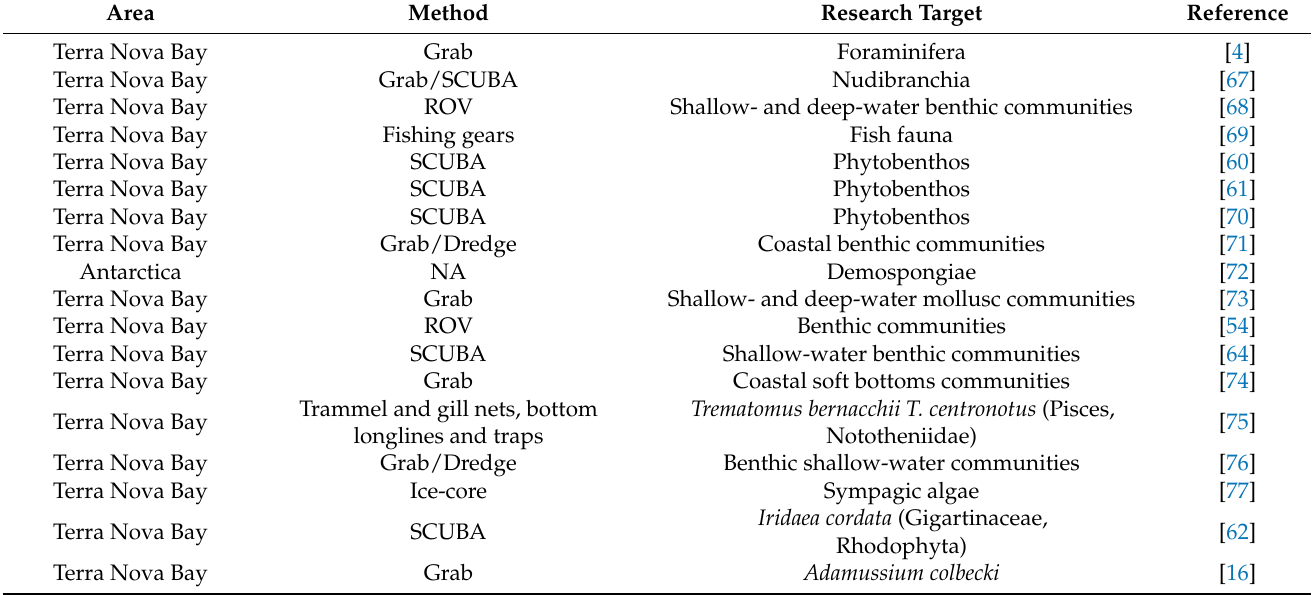
Table 1. Scientific literature reporting information on the biological components investigated and sampling methods for Terra Nova Bay. NA was used when sampling method was not recovered. SCUBA is the acronym for Self-Contained Underwater Breathing